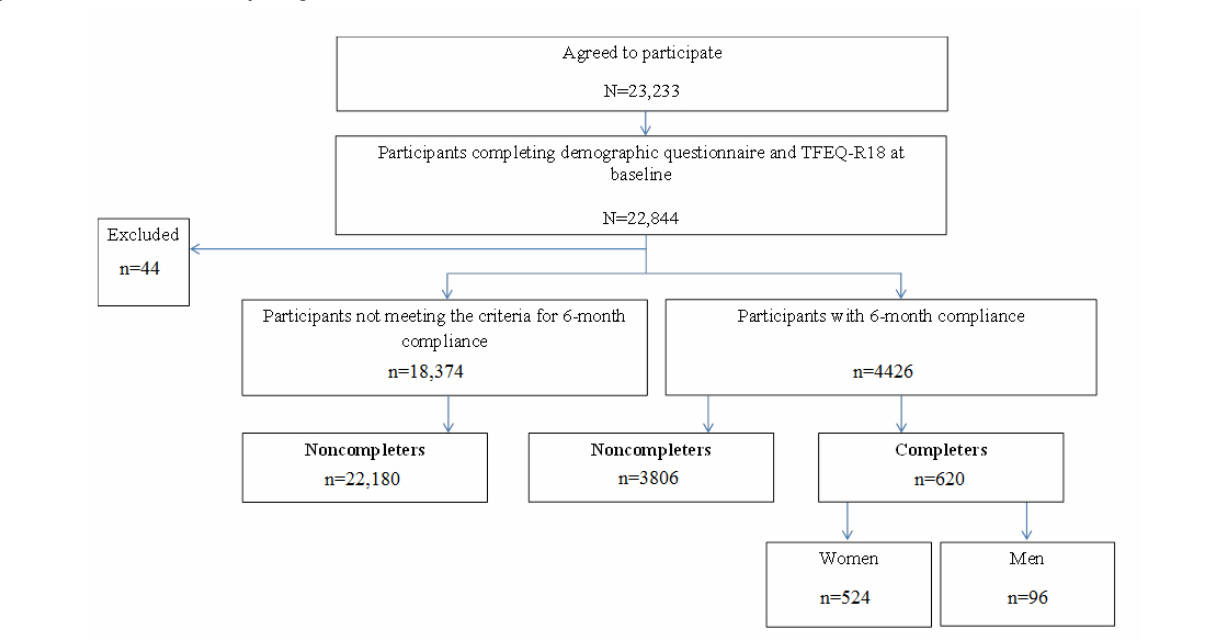
Figure 3. Flowchart of the study